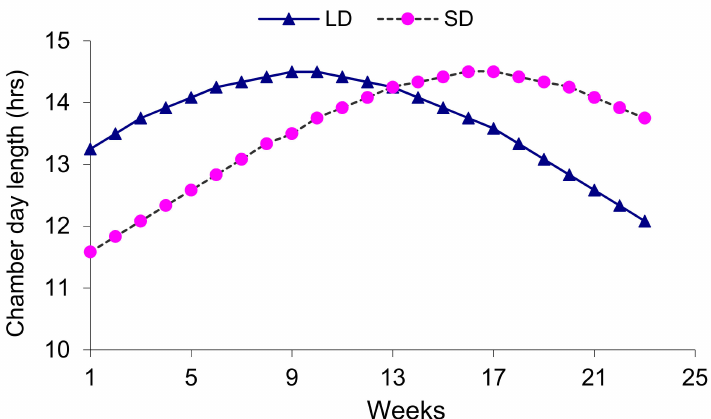
Figure 1. Daylength setting of the growth chambers for Long-day (LD) and Short-day (SD) plants. The LD and SD settings mimic farmers late (20 April) and early (1 March) planting seasons,